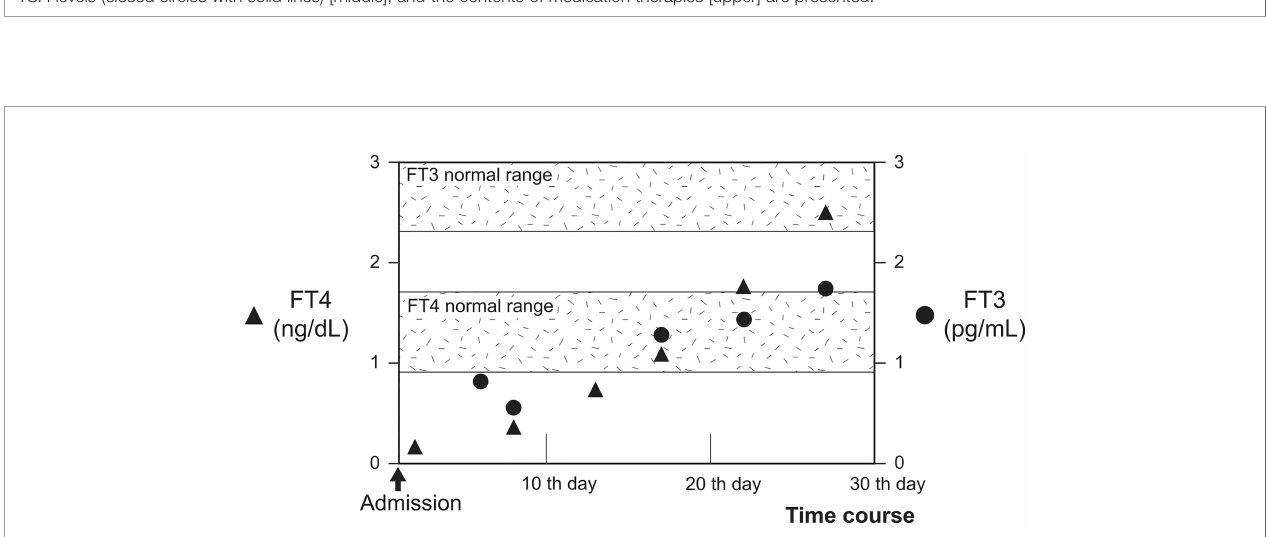
FIGURE 3 | Progress of FT3 and FT4 during hospitalization. Time course of serum FT4 and FT3 levels are shown. Serum FT4 and FT3 levels are denoted by closed triangles and circles, respectively. FT4 levels increased and reached above the normal range following levothyroxine administration after 20th day. However, FT3 levels did not increase suf fi ciently. The shadows represent the normal ranges of serum free T4 and free T3